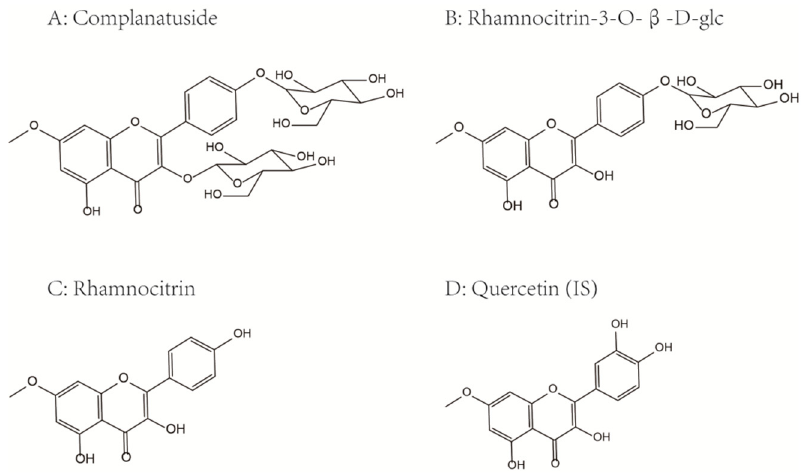
Figure 6. Chemical structures of complanatuside ( A ), rhamnocitrin 3- O - β -glc ( B ), rhamnocitrin ( C ), and quercetin ( D , IS).